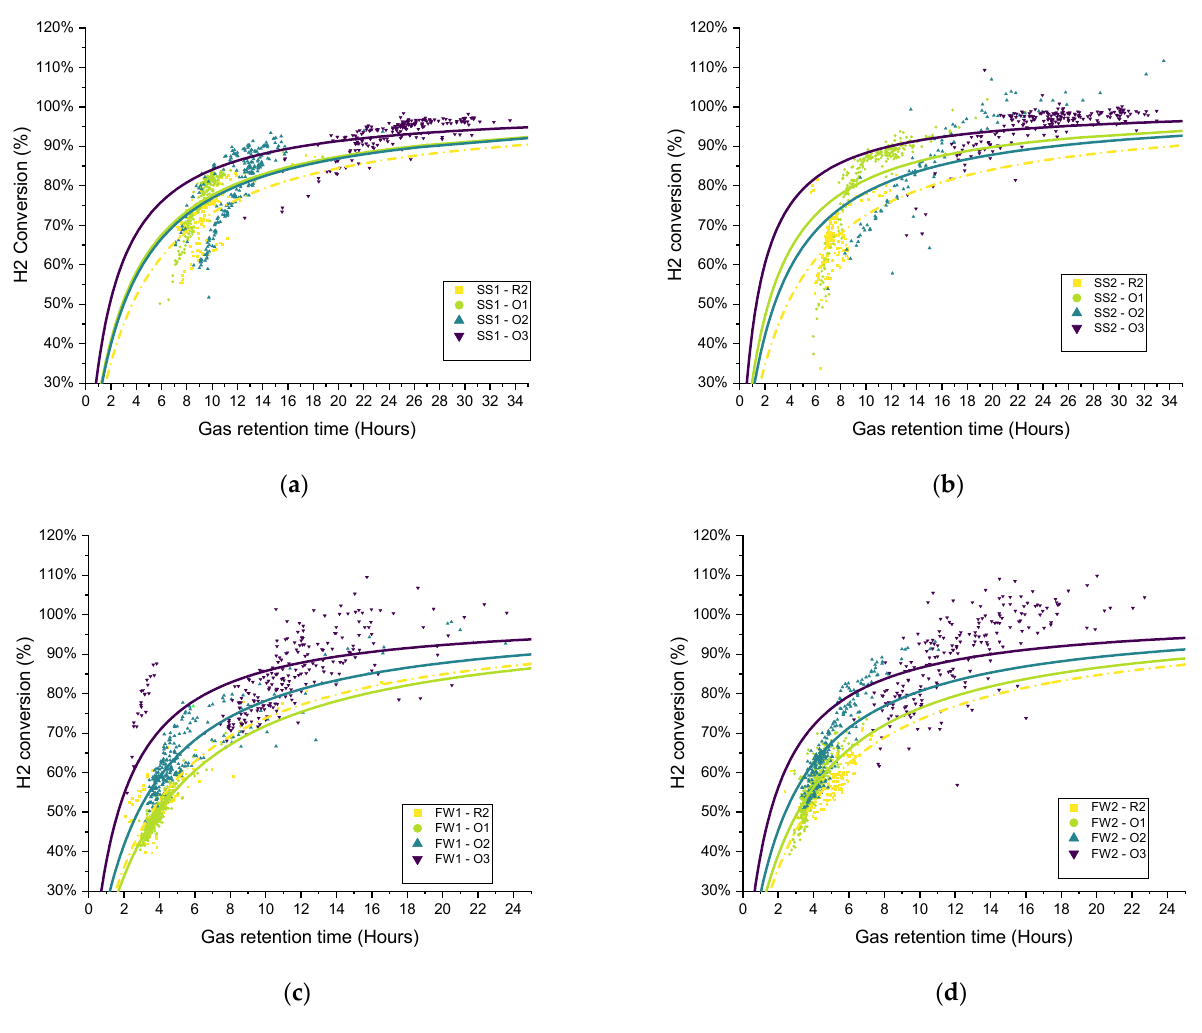
Figure 13. Scatter plot of the retention time and hydrogen conversion (two-hour periods average) with variations in operational conditions (O1–O3) for all biomethanation reactors:( a ) SS1, ( b ) SS2, ( c ) FW1, and ( d ) FW2).